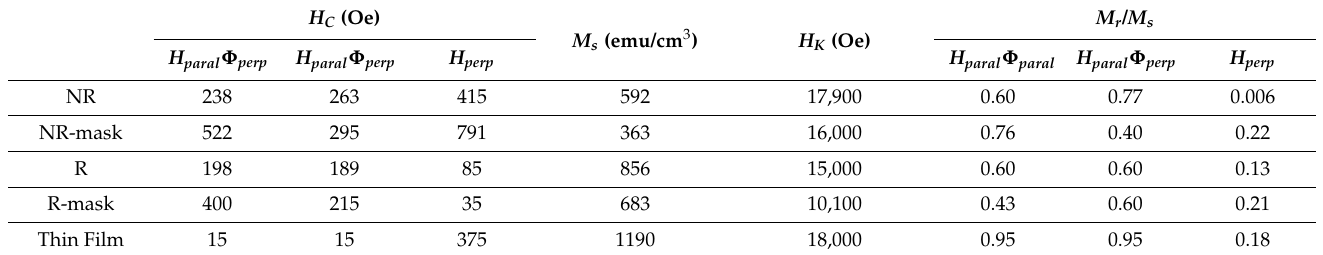
Table 2. Coercivity ( H C ), underestimated saturation magnetization ( M s ), anisotropy field ( H K ) and remanence-to-saturation magnetization ratio ( M r / M s ) for the NP samples and the reference thin film. H C and M r / M s are evaluated for the three directions of the magnetic applied field: 1—Parallel both to the substrate and to the atomic flux projection ( H paral Φ paral ), 2—Parallel to the substrate and perpendicular to the atomic flux projection ( H paral Φ per ), and 3—Perpendicular to the substrate ( H perp